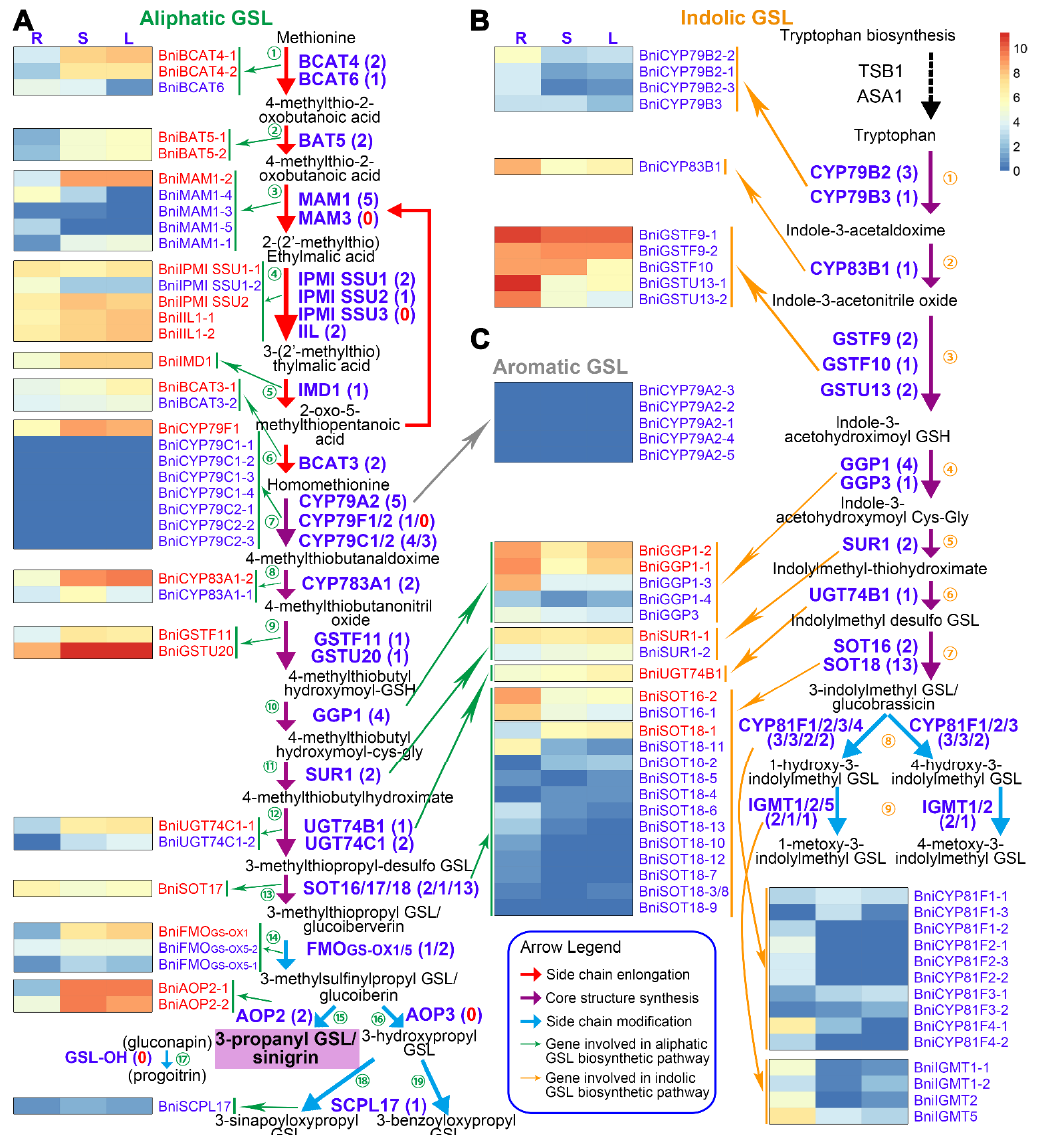
Figure 2. Biosynthetic pathways of aliphatic and indolic glucosinolates (GSLs) and the heatmap of related BniGSLs in Brassica nigra . The pathway contains 3 major phases: side-chain elongation (Steps 1–6), core structure synthesis (steps 7–13 in ( A ) and steps 1–7 in ( B )), and side-chain modification (steps 14–19 in ( A ) and steps 8 and 9 in ( B )). The biosynthetic pathway of aliphatic ( A ), indolic ( B ), and aromatic ( C ) GSLs and the heatmap of related BniGSLs . The number in parentheses represents the copy number of the gene. Abbreviations: AOP2, 2-oxoglutarate-dependent dioxygenase; BAT5, probable sodium/metabolite cotransporter BASS5; BCAT, branched-chain amino acid aminotransferase; CYP79A, phenylalanine N-monooxygenase; CYP79B, tryptophan N-monooxygenase; CYP79C/F, cytochrome P450 79C/F; CYP83B, CYP83B monooxygenase; FMO GS-OX , flavincontaining monooxygenase; GGP1, γ -glutamyl peptidase 1; GSTF/U, glutathione S- transferase F/U; GTR, GSL transporter; IGMT, indole GSL O-methyltransferase; IIL1, isopropylmalate isomerase large subunit 1; IPMI-SSU, isopropylmalate isomerase small subunit; L, leaf; MAM, methylthioalkylmalate synthase; R, root; S, stem; SOT, sulfotransferase. The framework of the aliphatic and indolic biosynthetic pathways is adapted from ref [11].